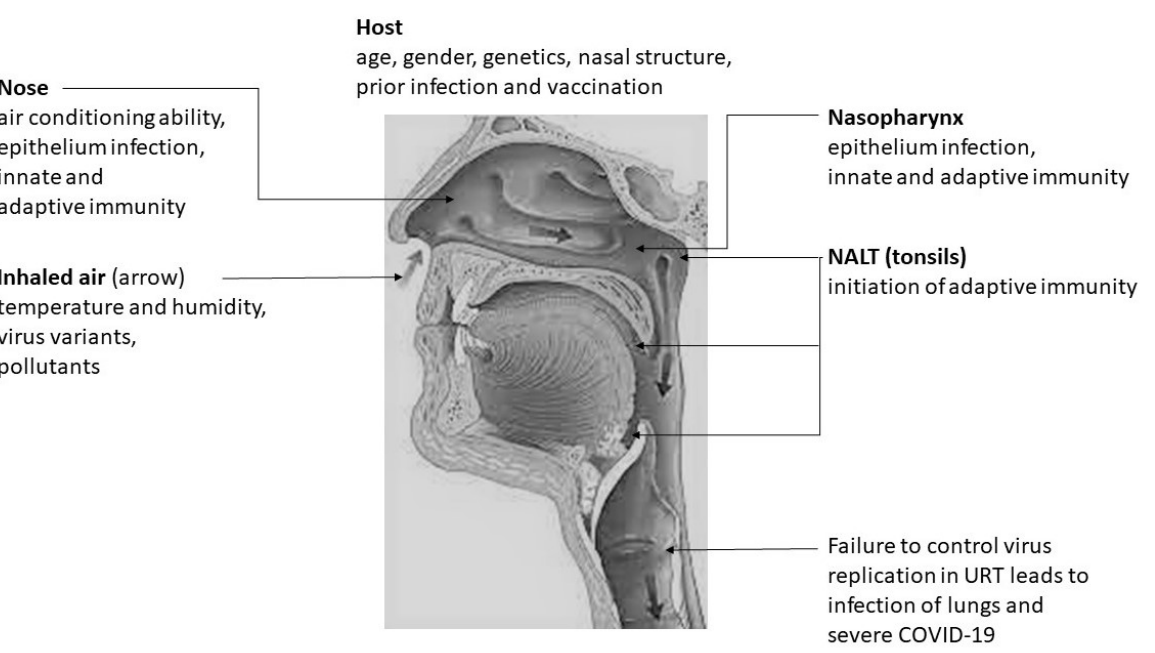
Figure 1. Relationship between the nasal conditioning of inhaled air and SARS-CoV-2 infectivity in the upper respiratory tract.